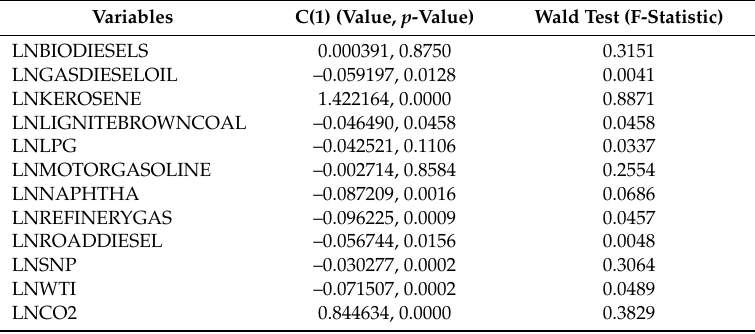
Table 8. The outcomes of the C(1) coe ffi cient and Wald test.